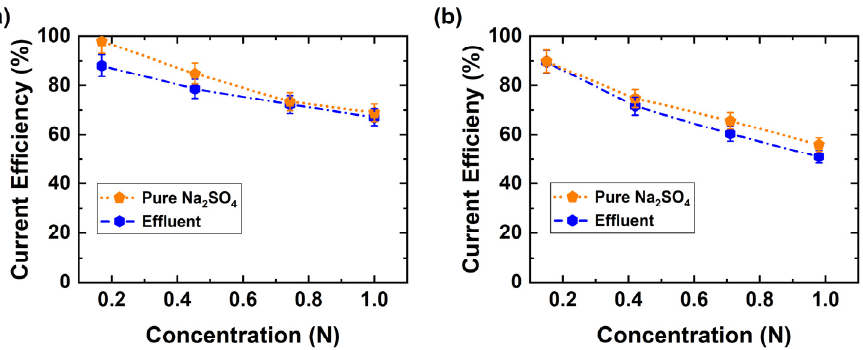
Figure 7. Current efficiency variation as a function of BPED products using pure Na 2 SO 4 or the industrial effluent. ( a ) Base, ( b ) Acid (300 A m − 2 at room temperature).